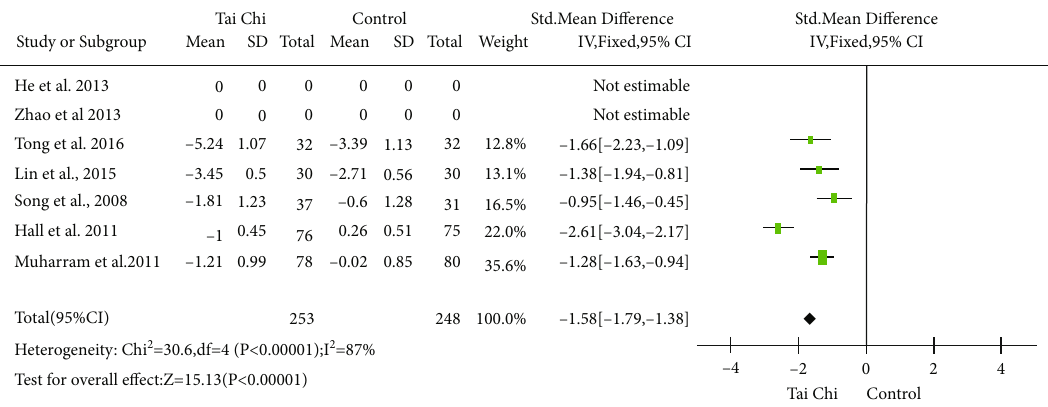
Figure 2: Forest plot analysis of the e ff ect of Tai Chi for pain. Table 3: Tai Chi with routine therapy vs. routine therapy.